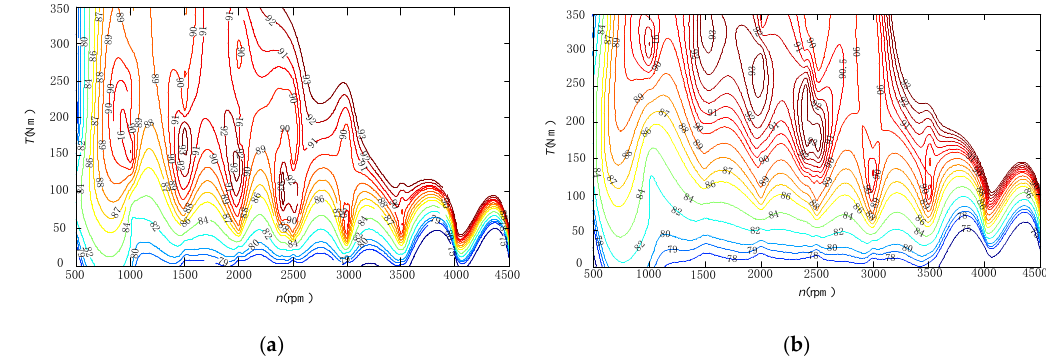
Figure 3. ( a ) Working mode a system map diagram; ( b ) Working mode b system MAP diagram.